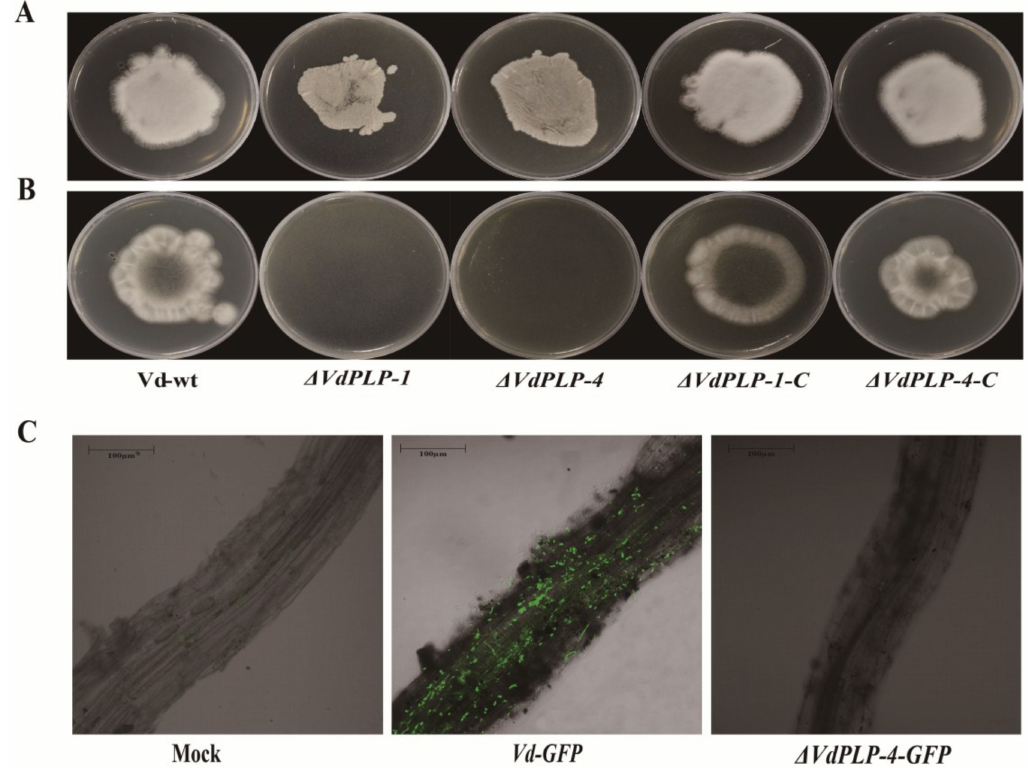
Figure 6. Fungal colonization and penetration assay: ( A ) Vd-wt, ∆ VdPLP and ∆ VdPLP-C strains grown on cellophane for three days after strains had penetrated a cellophane membrane on the agar plate and membranes were removed; ( B ) plates after incubation at 25 ◦ C for seven days after cellophane were removed; and ( C ) fungal colonization of infected roots by the ∆ VdPLP-4-GFP mutant strains, Vd-GFP strain, and sterile water (Mock), three days after